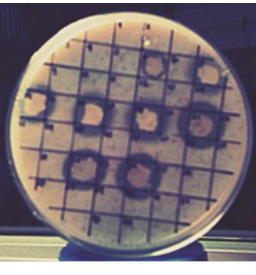
Figure 2: Halo hydrolysis presented by the strains after 24 hours of incubation at 37°C in marine agar with 2% skim